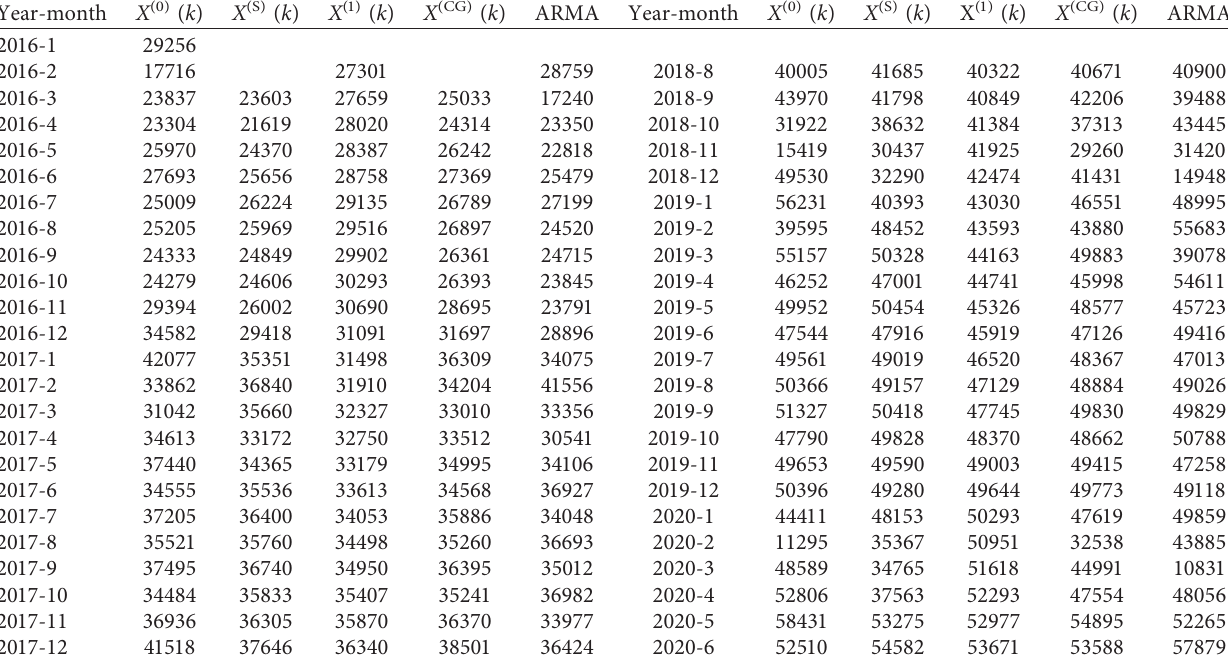
Table 2: Grey transformation data of Mercedes Benz